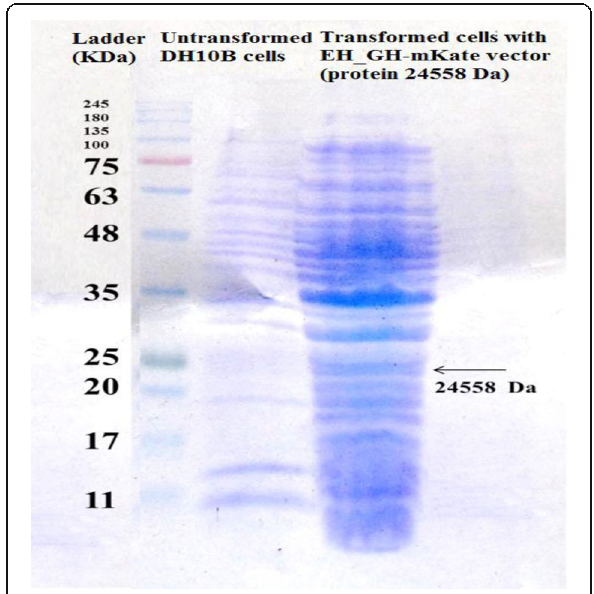
Fig. 6 SDS-PAGE of the expressed proteins of untransformed DH10B